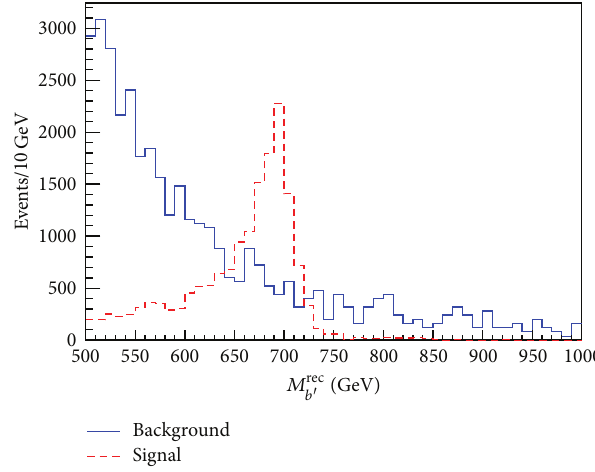
Figure19:Thereconstructedmassdistributionsforbackgroundand signal ( 𝑏𝛾 ) with 𝑚 𝑏 󸀠 = 700 GeV and 𝜅/Λ = 0.3 TeV −1